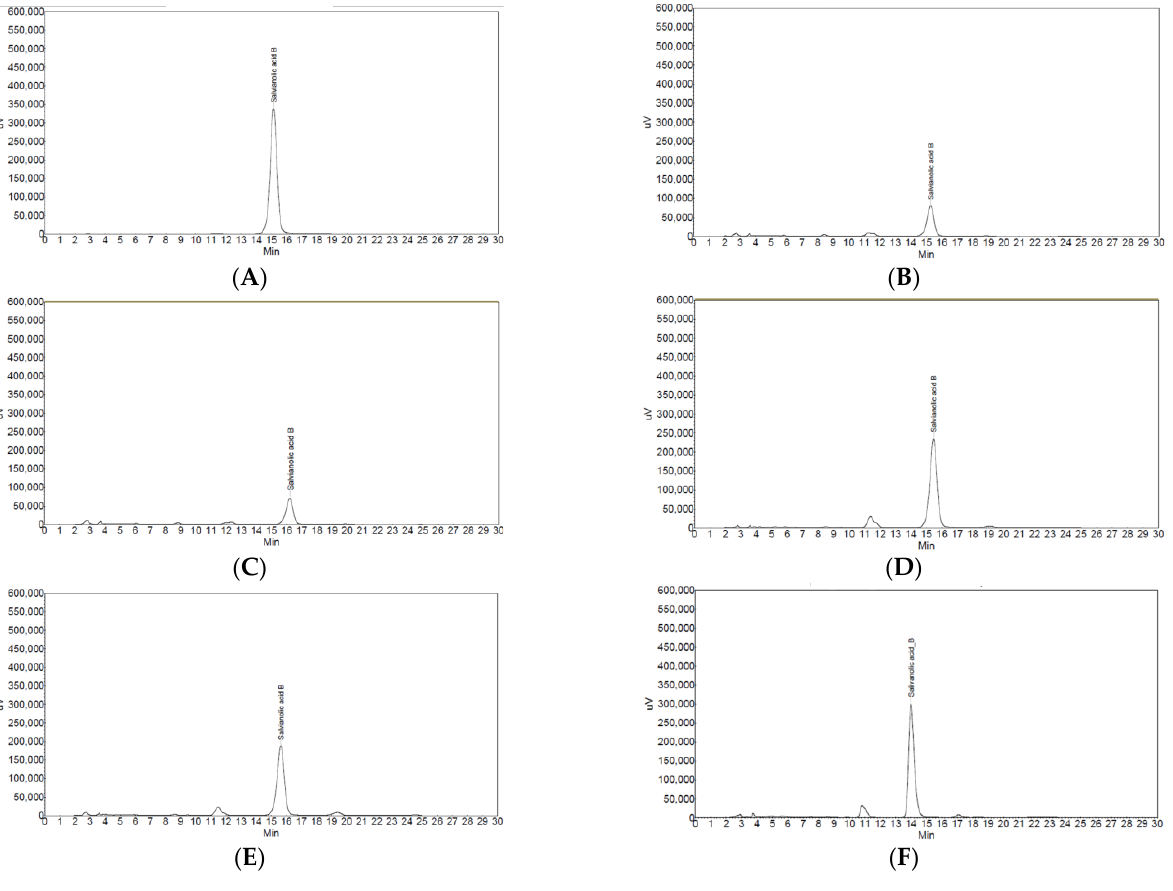
Figure 1. Results of high-performance liquid chromatography chromatogram for the salvianolic acid B in five types of Salviae mitiorrhizae Radix. ( A ) Standardized salvianolic acid B. ( B ) Salvianolic acid B in C1. ( C ) Salvianolic acid B in C2. ( D ) Salvianolic acid B in K1. ( E ) Salvianolic acid B in K2. ( F ) Salvianolic acid B in K3. K1, K2, and K3 showed high peak values similar to that of the standardized salvianolic acid B. C1 and C2 showed low peak values. C, Chinese Salviae miltiorrhizae Radix; K, Korean Salviae miltiorrhizae Radix. Table 2. The contents of salvianolic acid B in five kinds of Salviae Mitiorrhizae Radix. Drugs